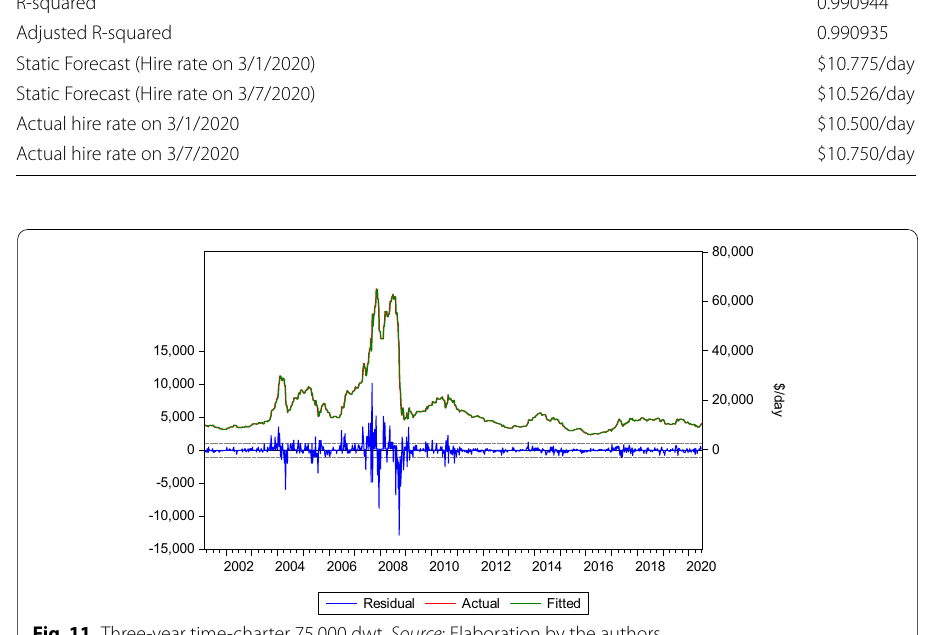
Table 10 Three-years time-charter 75.000 dwt. Source : Elaboration by the authors R-squared 0.990944 Adjusted R-squared 0.990935